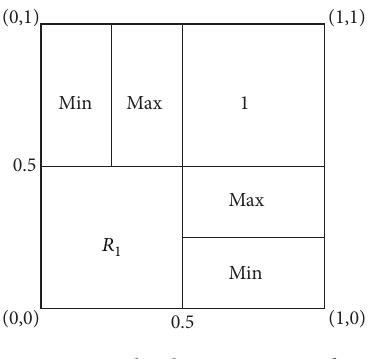
Figure 1: Graphical representation of 𝑅 5